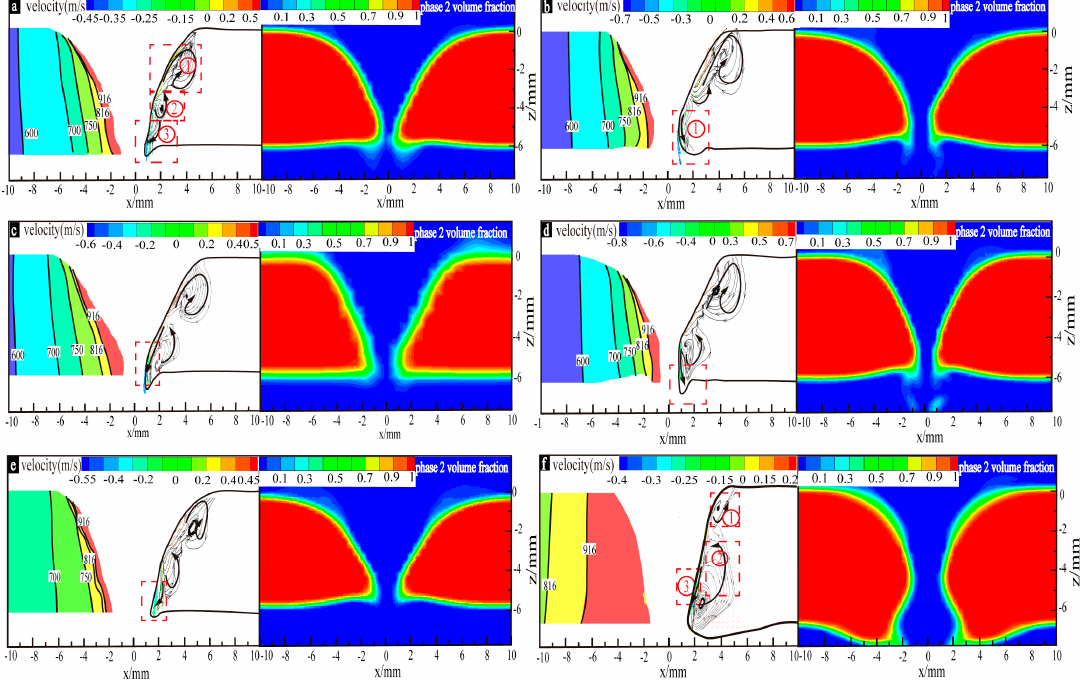
Figure 15. The temperature of the weld pool in the critical state of the keyhole perforation for case a- f . ( a ) Temperature gradient from 0 mm to the weld center. ( b ) Temperature gradient from 6 mm to the weld center. In Figure 14a–f, under the action of the surface tension and the digging effect of the arc pressure, the upper molten metal of the weld pool flows outwards and then forms clockwise, as shown in Figure 14a ① ; The molten metal in the middle of the weld pool flows upwards and inwards, as shown in Figure 14a ② , under the digging action of the arc pressure, the electromagnetic force, and the effect of clockwise eddy flow in Figure 14a ① ; in particular, the material flow behavior in the lower part of the weld pool is quite different. In case a, case c and case e, the molten metal forms confluences towards the keyhole center, as shown in Figure 14a ③ , at the maximum velocities of 0.45 m/s, 0.55 m/s and 0.6 m/s, respectively, with moderate temperature gradients (the slopes values being greater than 0.7 and less than 0.87), as shown in Figure 15b. In case b and case d, the molten metal of the weld pool bottom flows downwards and outwards, as shown in Figure 14b ① , at the maximum speed of 0.7 m/s and 0.8 m/s, respectively, under the action of the large surface tension caused by the